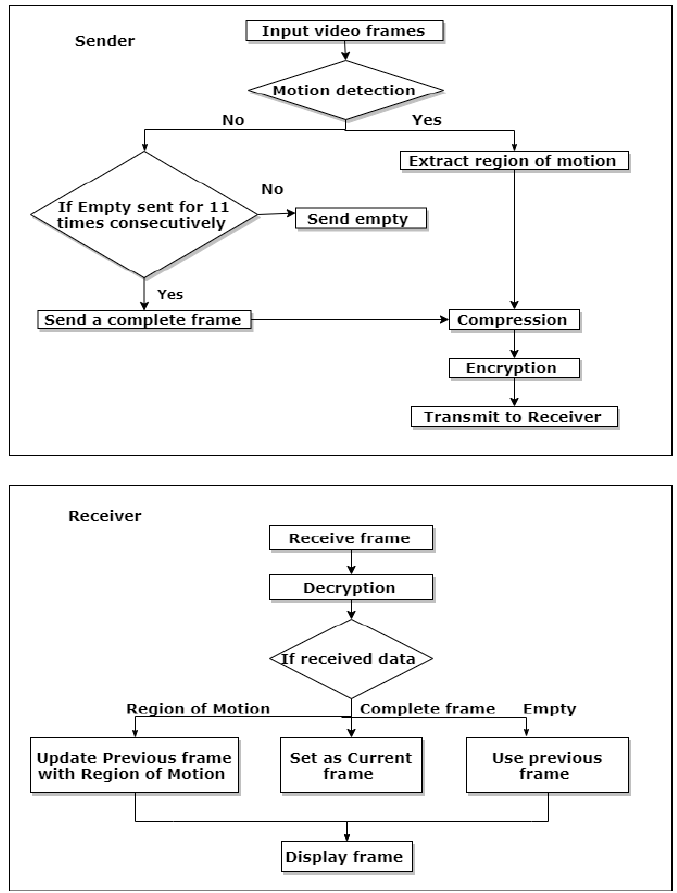
Figure 4. Processing steps at a sender and at a